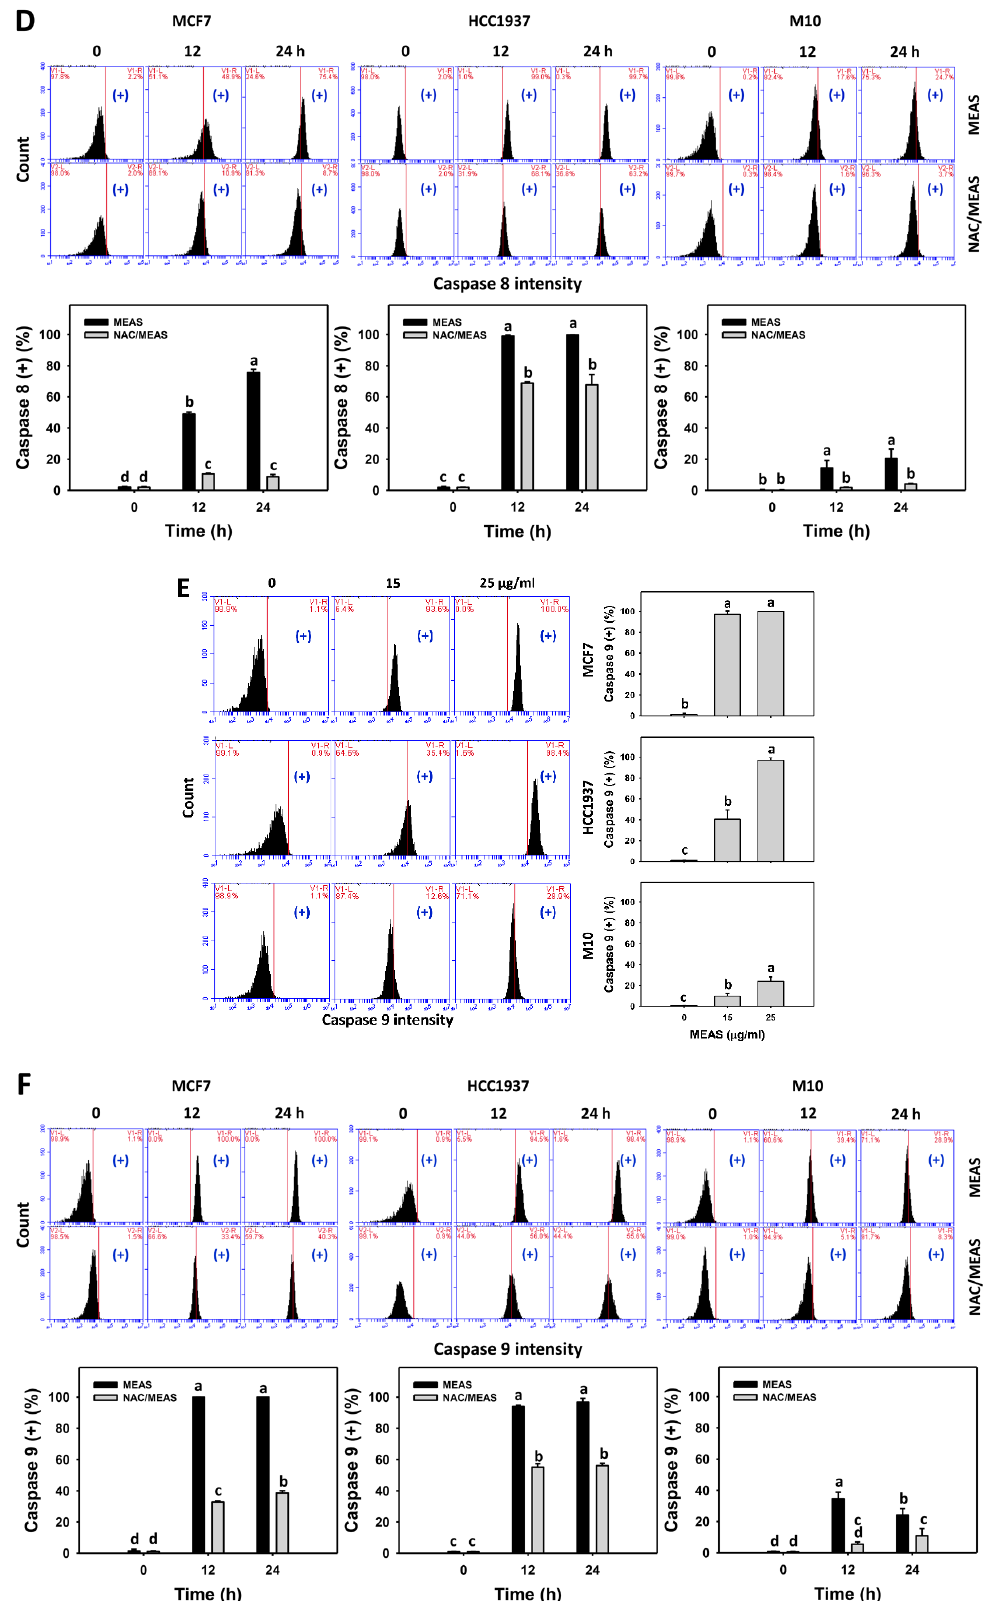
Figure 5. MEAS increased activation of Caspases 3, 8, and 9 of breast cancer cells. ( A , C , E ) Caspases